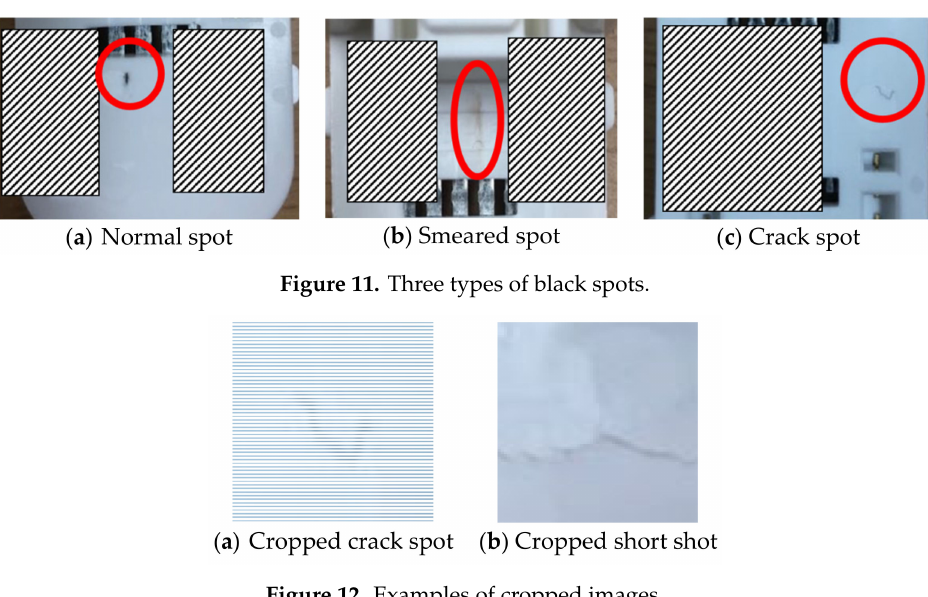
Figure 12. Examples of cropped